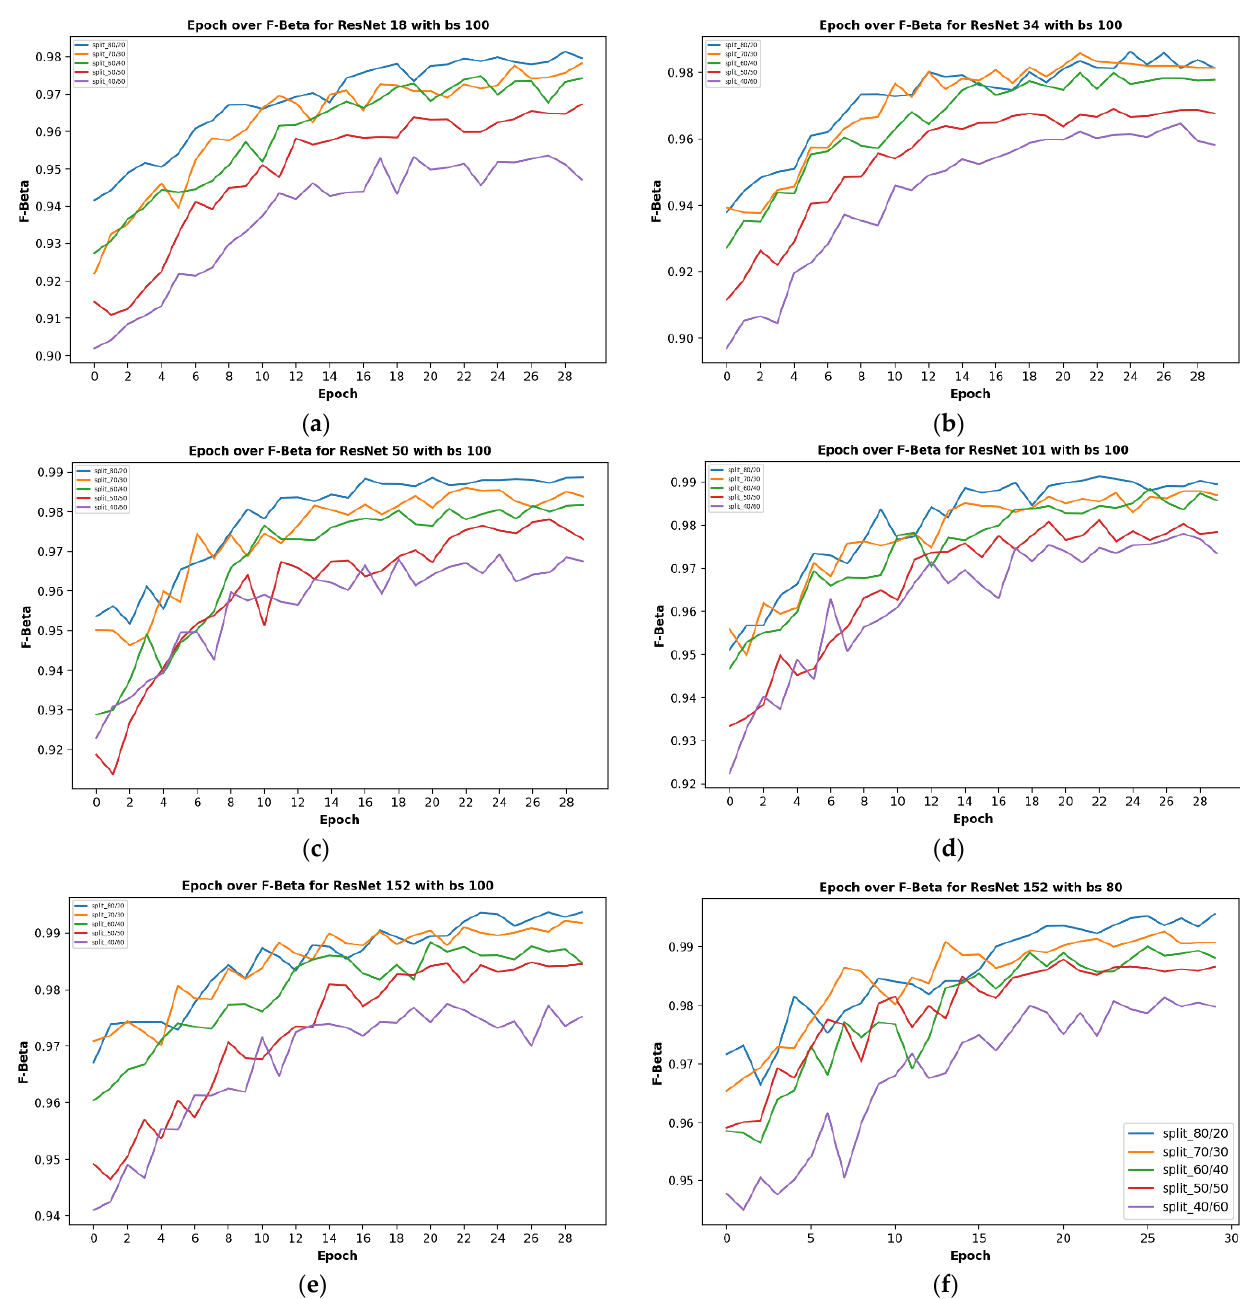
Figure 1. Showing the results on different train/test split ratios on various models used in our research: ( a ) showing epoch over F1 score for ResNet-18; ( b ) showing epoch over F1 score for ResNet- 34; ( c ) showing epoch over F1 score for ResNet-50; ( d ) showing epoch over F1 score for ResNet-101; ( e ) showing epoch over F1 score for ResNet-152; ( f ) showing epoch over F1 score for ResNet-152 on a batch size of 80, this is where the best F1 score of our research is located.